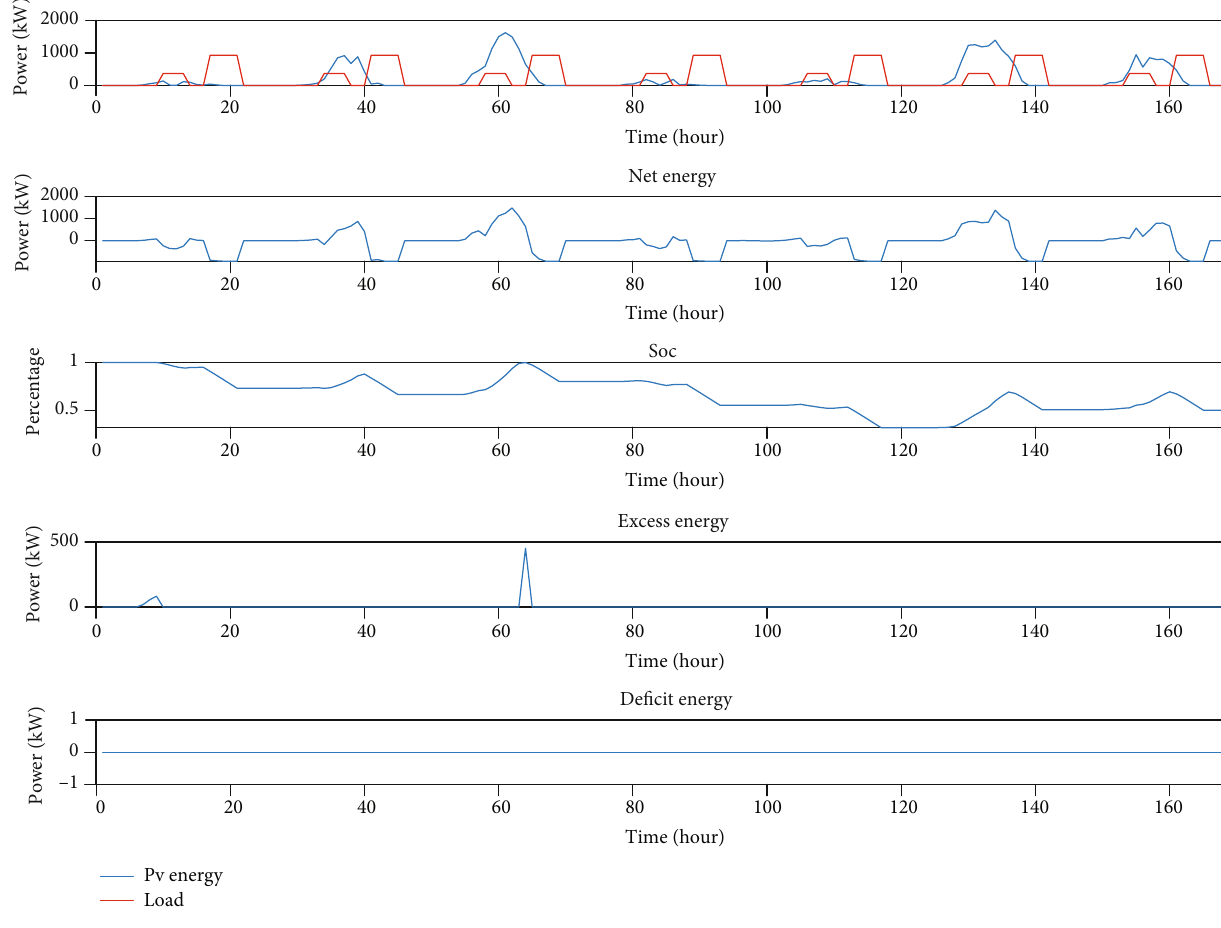
Figure 17: System performance sample for the third scenario: Nablus